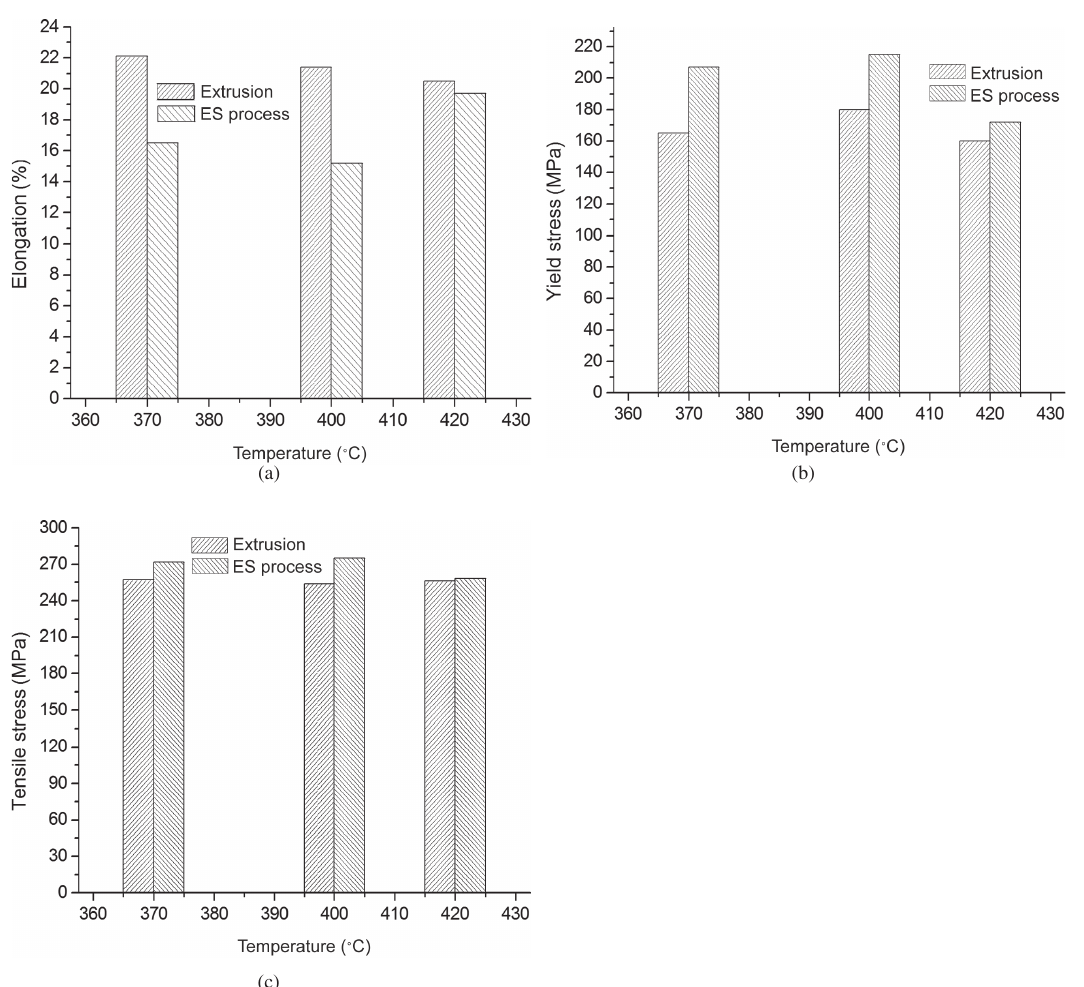
Figure 7: Effects of billet temperatures on properties of Mg alloy fabricated by ES process and direct extrusion at different temperatures: (a) elongation, (b) yield strength and (c) tensile